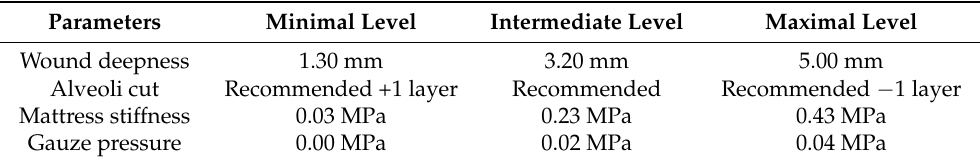
Table 3. Parameter coefficients and polynomial model sensitivities (>1%) in decreasing order of magnitude.